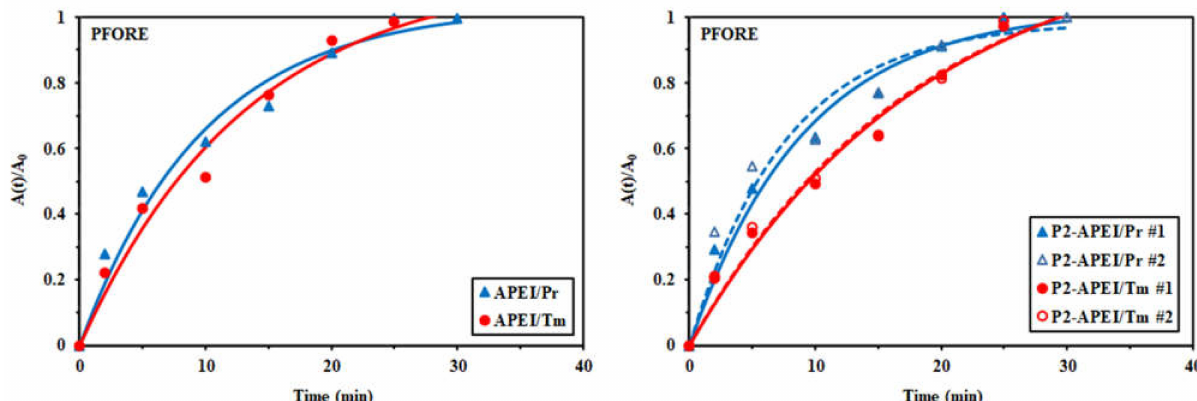
Figure 9. Pr(III) and Tm(III) desorption kinetics for APEI and P2-APEI—modeling with the PFORE (loaded sorbents collected from uptake kinetics; desorption using 0.2 M HCl/0.5 M CaCl 2 ; SD: 1 g L − 1 , T: 22 ± 1 ◦ C; A(t)/A 0 : metal amount desorbed referred to initial sorbed